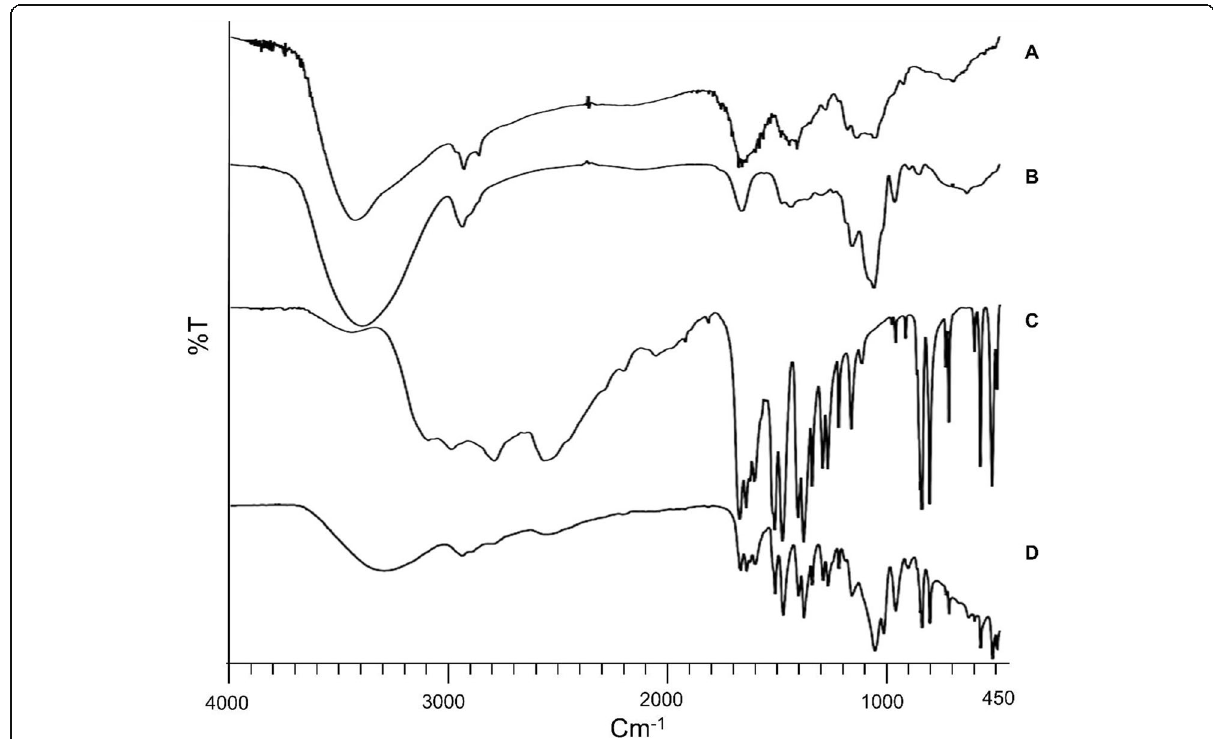
Fig. 7 FTIR spectra of ( A ) chitosan, ( B ) CMI, ( C ) mesalamine, and ( D ) chitosan-CMI